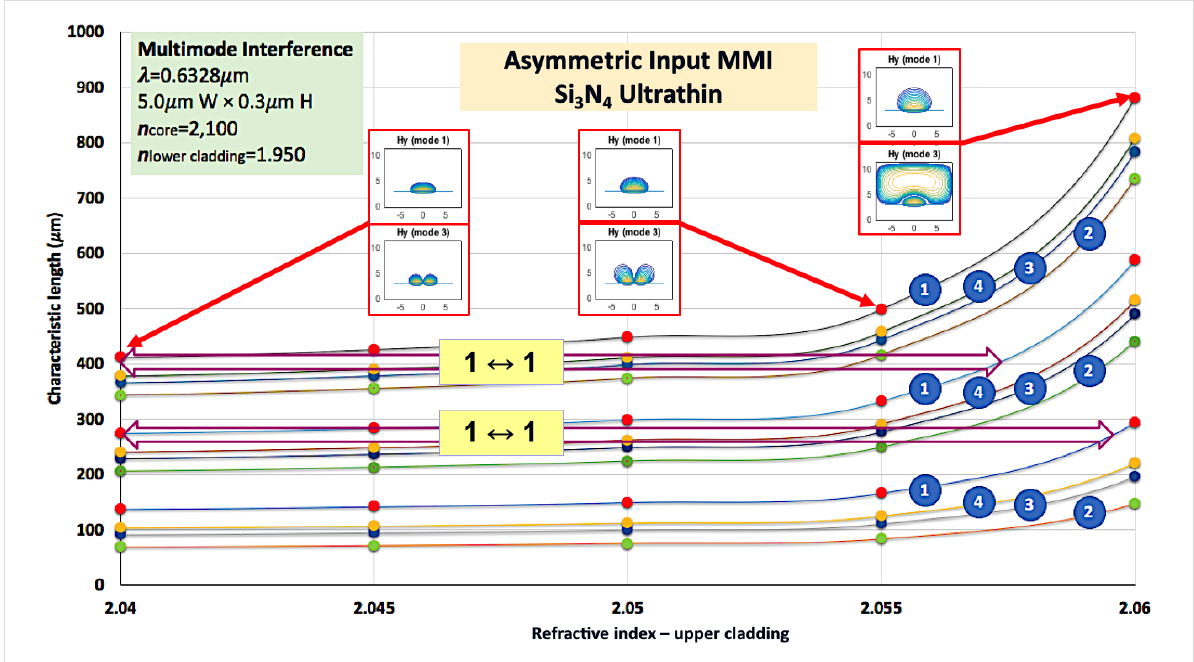
Figure 7: An MMI with inorganic Si 3 N 4 core and high-birefringence LC cladding does not show variations in characteristic length, unless the wave- guide thickness is significantly reduced. In this case, a working range for optical switches can be found.